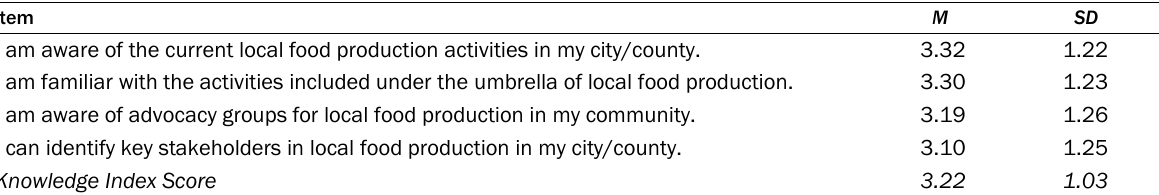
Table 3. Self-Perceived Knowledge of Local Food Production Topics ( n=